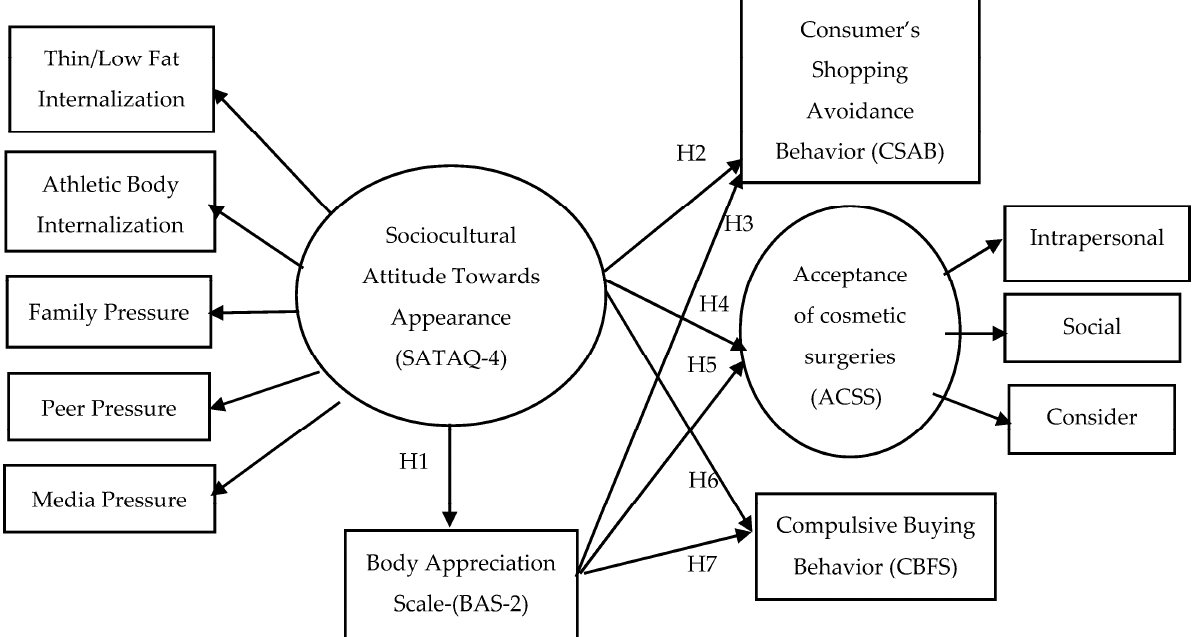
Figure 1. Conceptual model of the assessment of shopping behaviour implications resulting from body dissatisfaction (study no. 1).